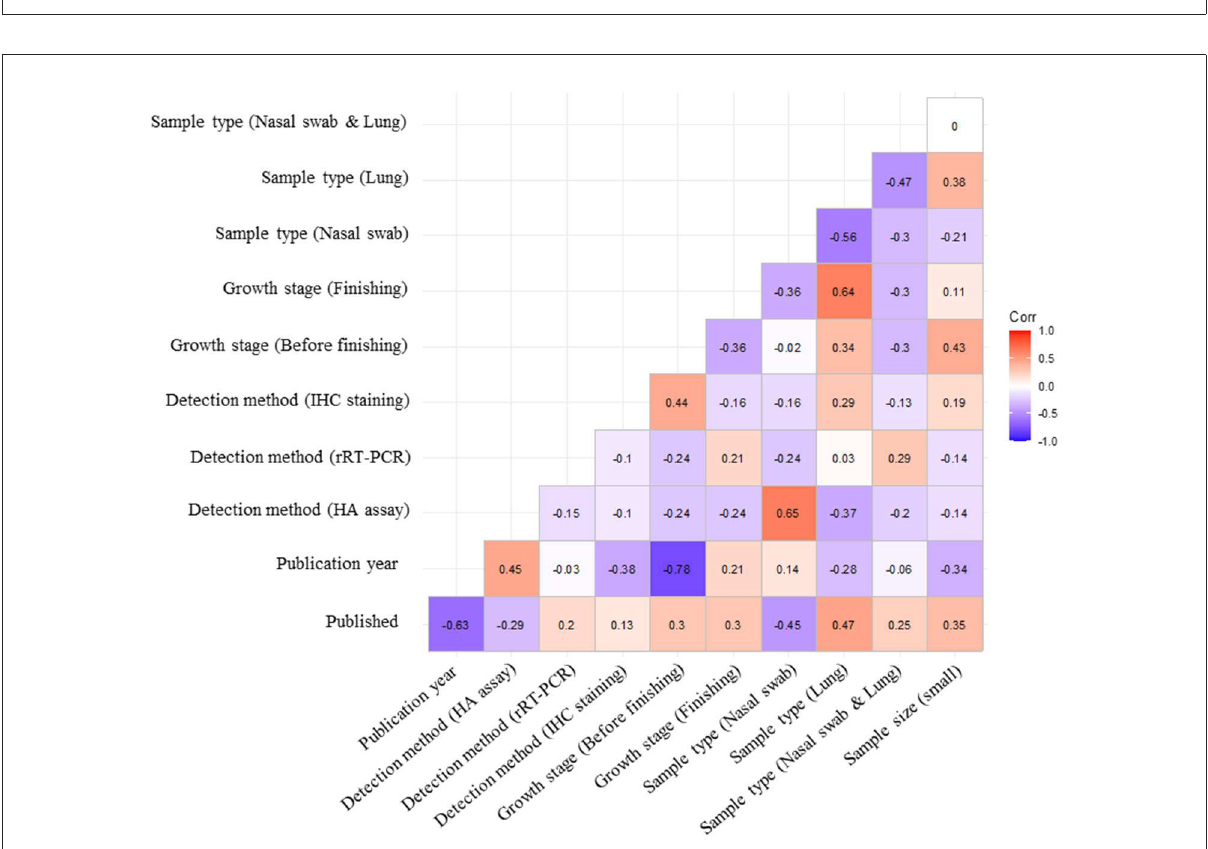
FIGURE3 Assessment of the degree of association between the covariates. Each subcategory of covariates is listed on both the x- and y-axes. Spearman’s rank correlation coefficient ( ρ ) was computed to evaluate multicollinearity among each covariate.